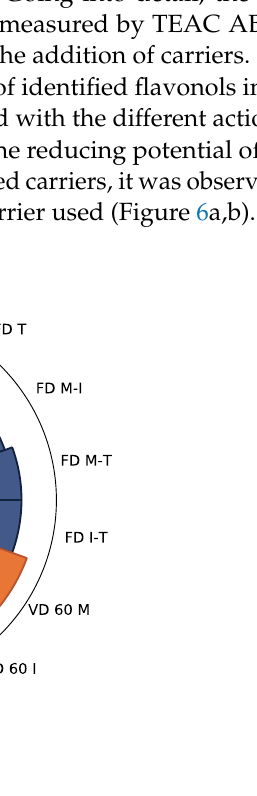
Figure 6. The radar plot of TEAC ABTS ( a ) and FRAP ( b ) of chokeberry pomace extract powders gained with the addition of maltodextrin (M), inulin (I), trehalose (T), maltodextrin—inulin (M—I), maltodextrin—trehalose (M—T), and inulin— trehalose (I—T) by freeze drying (FD) and vacuum drying at 60 (VD 60) and 90 °C (VD 90) ( n = 2) (mmol Trolox/100 g db).